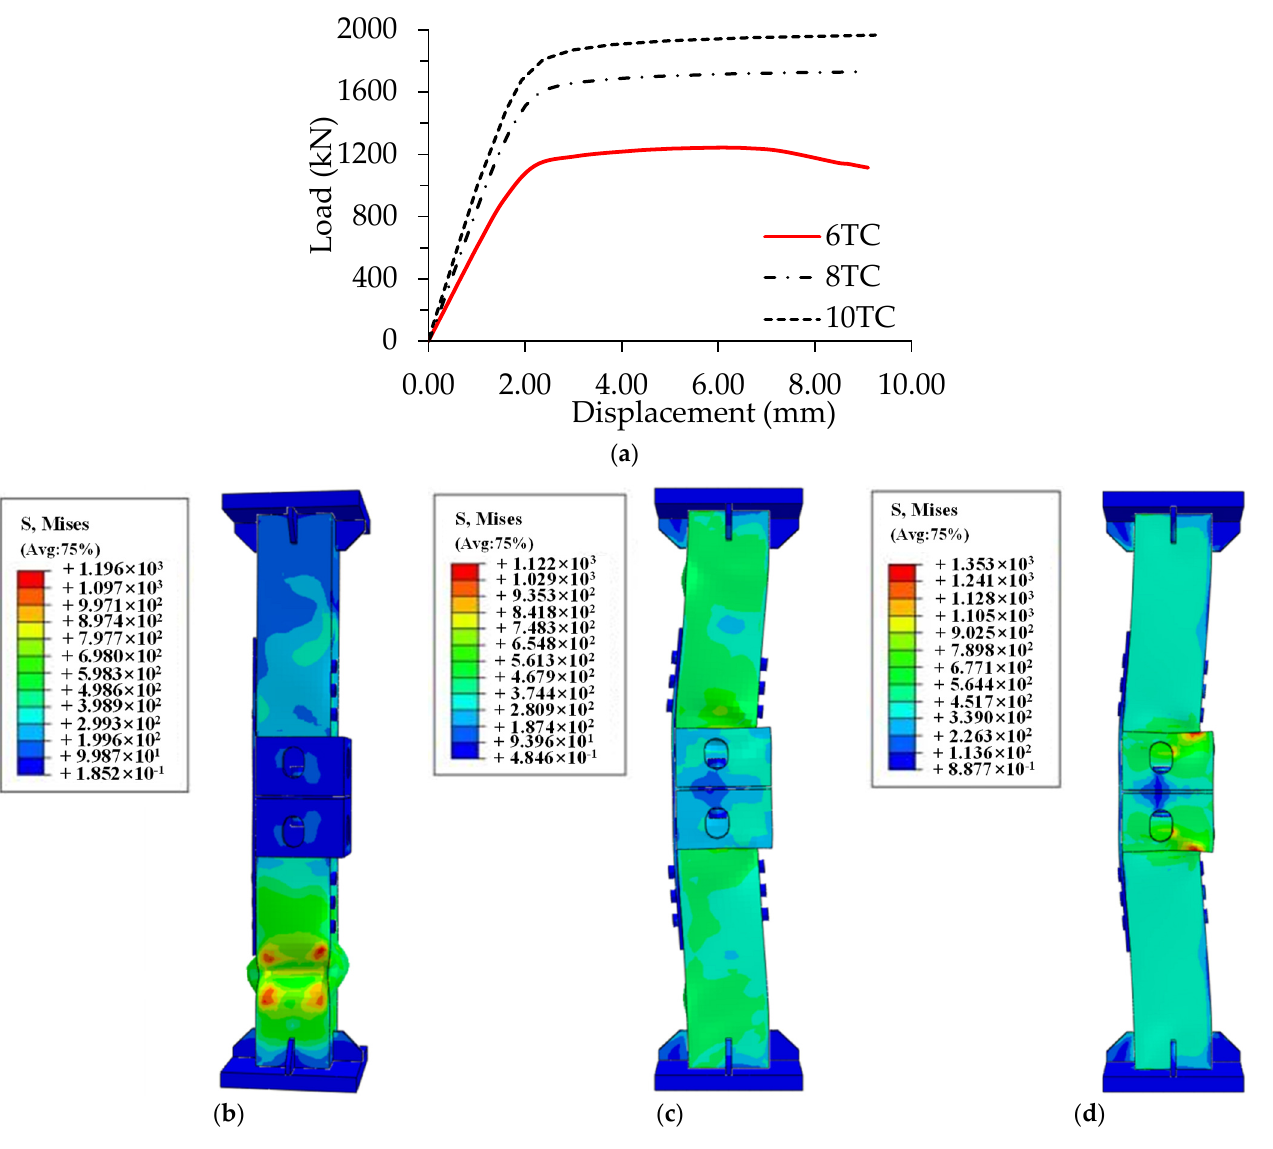
Figure 23. Comparisons of different thickness of the columns: ( a ) original models with 0% weight reduction; ( b ) failure mode of six TC model; ( c ) failure mode of 8 TC model; ( d ) and failure mode of 10 TC model.